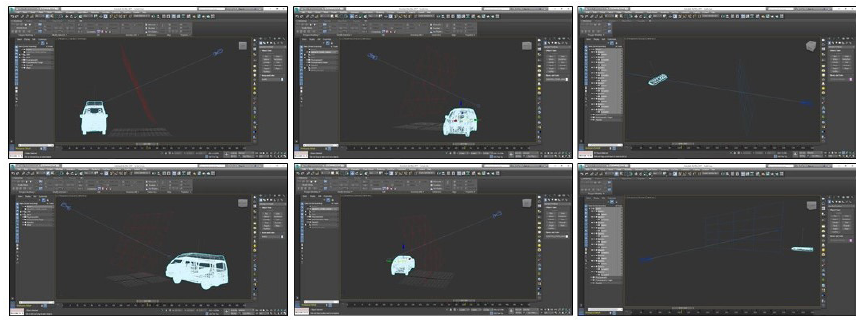
Fig. 4. Composing the camera to the objects